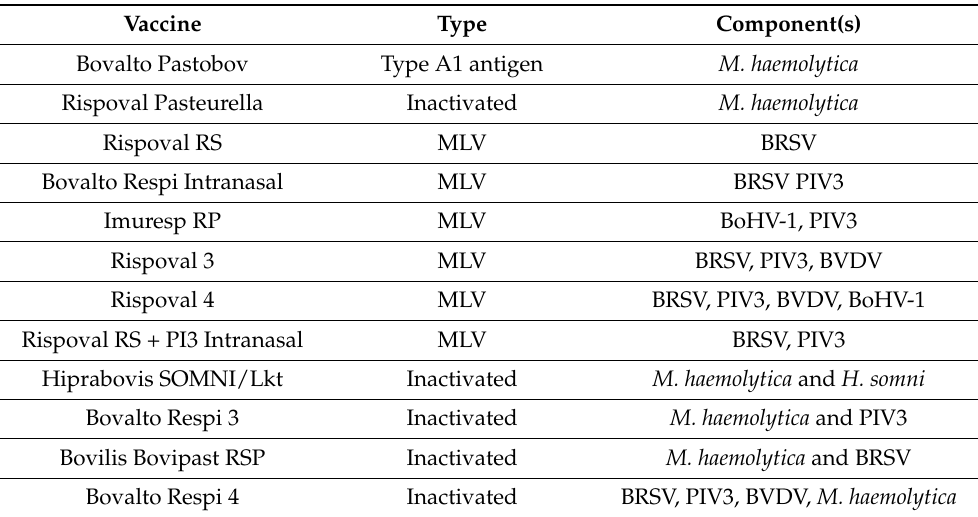
Table 1. Commercially available BRDC vaccines. An overview of the viral and bacterial vaccinations available as of February